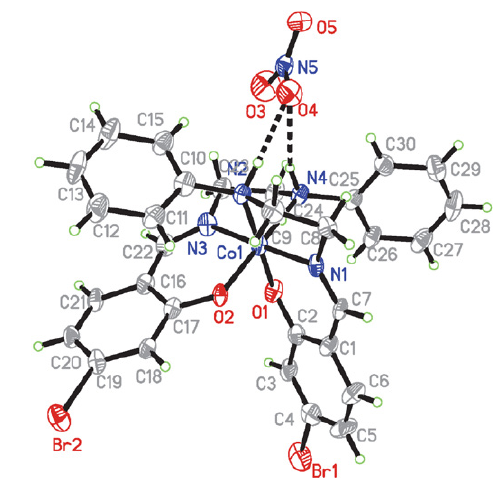
Fig. 1. Molecular structure of complex 1